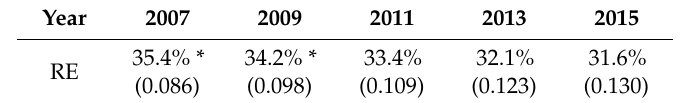
Table 6. Calculation results of direct rebound effect for urban residents ’ electricity consumption. Year